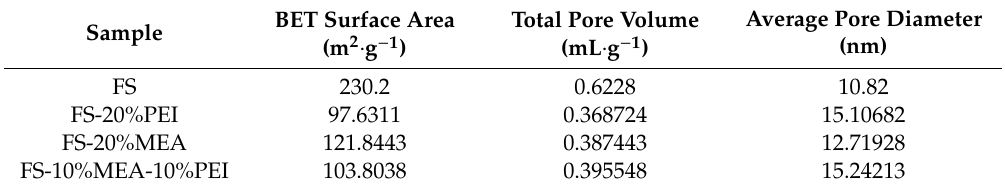
Table 1. Textural properties of the silica before and after impregnating organic amine.